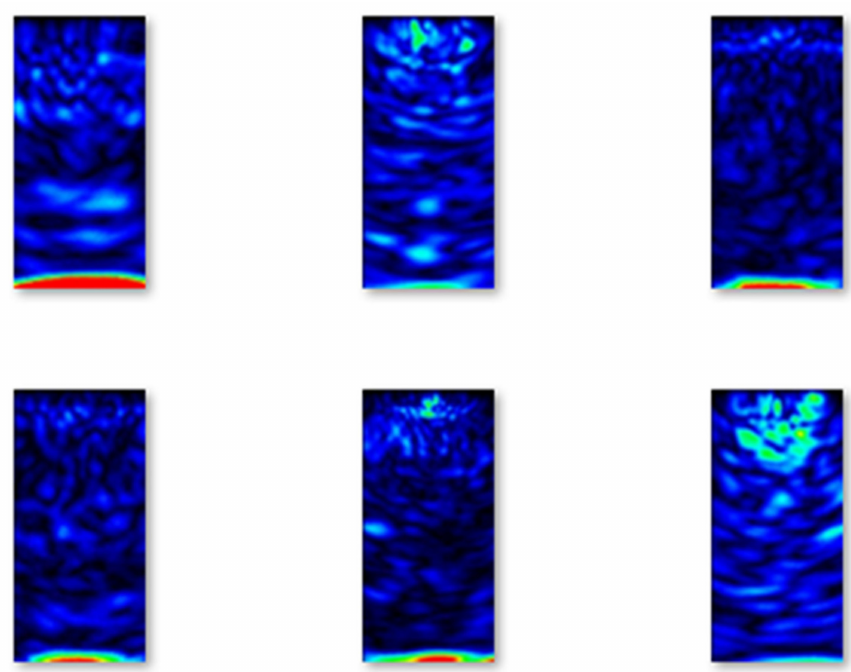
Figure 5. Selected examples of B-scans without flaws from the training set.